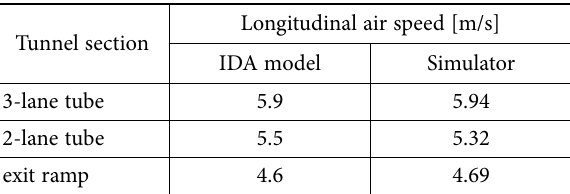
Table. Comparison of simulated longitudinal air speeds during